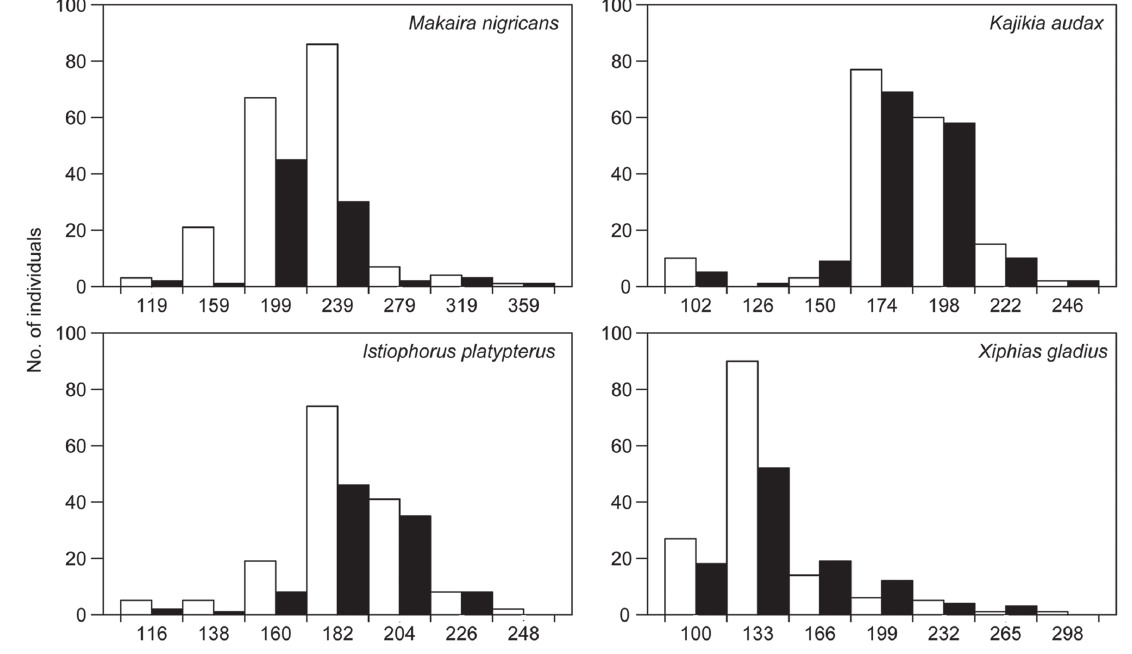
Fig. 2. Combined length-frequency distribution of empty stomachs (white bars) and stomachs containing prey (black